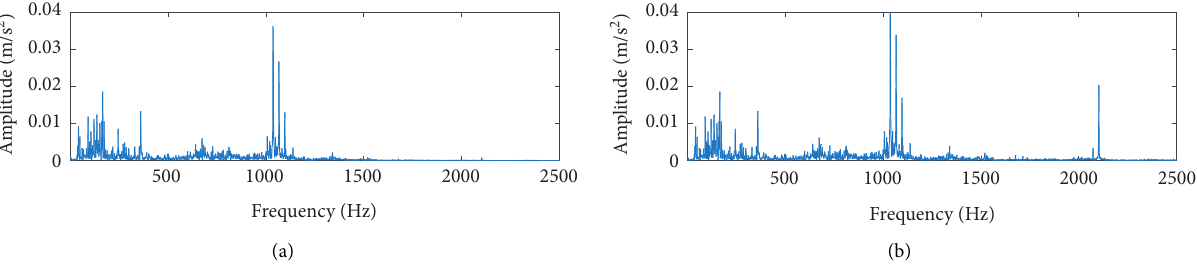
Figure 8: The spectrum of vibration signal (a) using smooth filtering and (b) using SCICA-FD with smooth